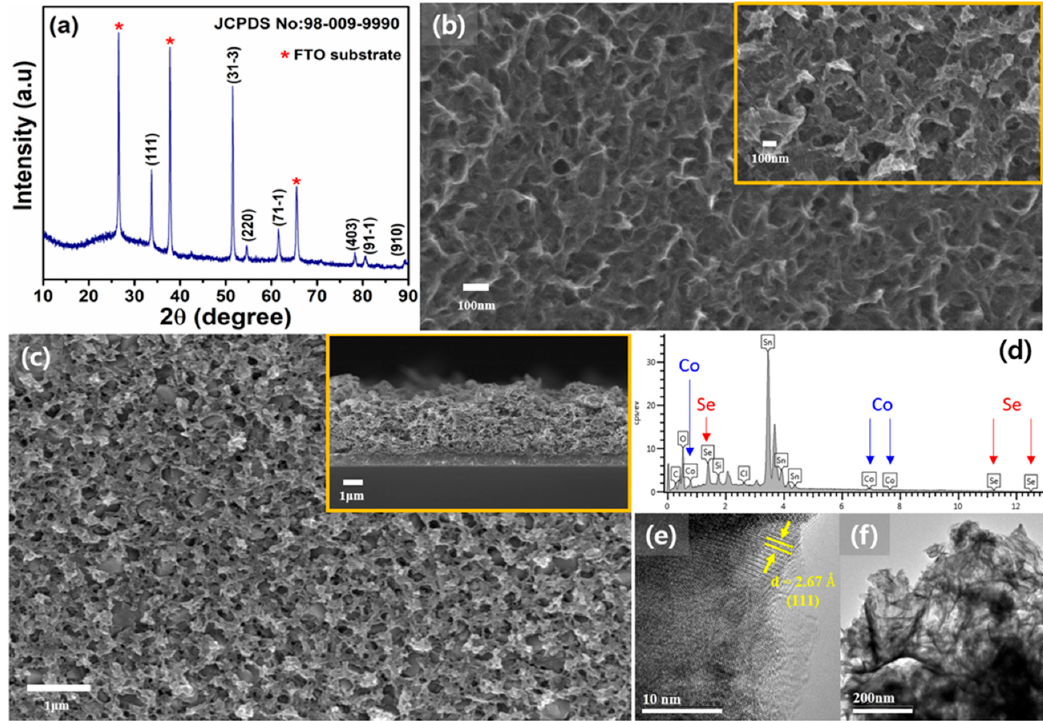
Figure 1. Surface characterization of the Co 3 Se 4 film: ( a ) XRD (x ‐ ray diffraction) pattern of electrodeposited Co 3 Se 4 on FTO (fluorine doped tin oxide). ( b ) Plan ‐ view FESEM (field ‐ emission scanning electron microscope) images of electrodeposited Co 3 Se 4 on GC electrode. ( c ) Plan ‐ view and cross ‐ sectional (inset) FESEM images of electrodeposited Co 3 Se 4 on FTO electrode. Different but conducting electrode substrates result in the same 3D porous structure of Co 3 Se 4 film through the electrodeposition process. ( d ) Energy dispersive spectrometry spectrum showing the presence of cobalt and selenide elements and ( e ) High ‐ resolution transmission electron microscopy (HR ‐ TEM) image to identify Co 3 Se 4 . ( f ) TEM (transmission electron microscopy) image showing uniformly deposited Co 3 Se 4.